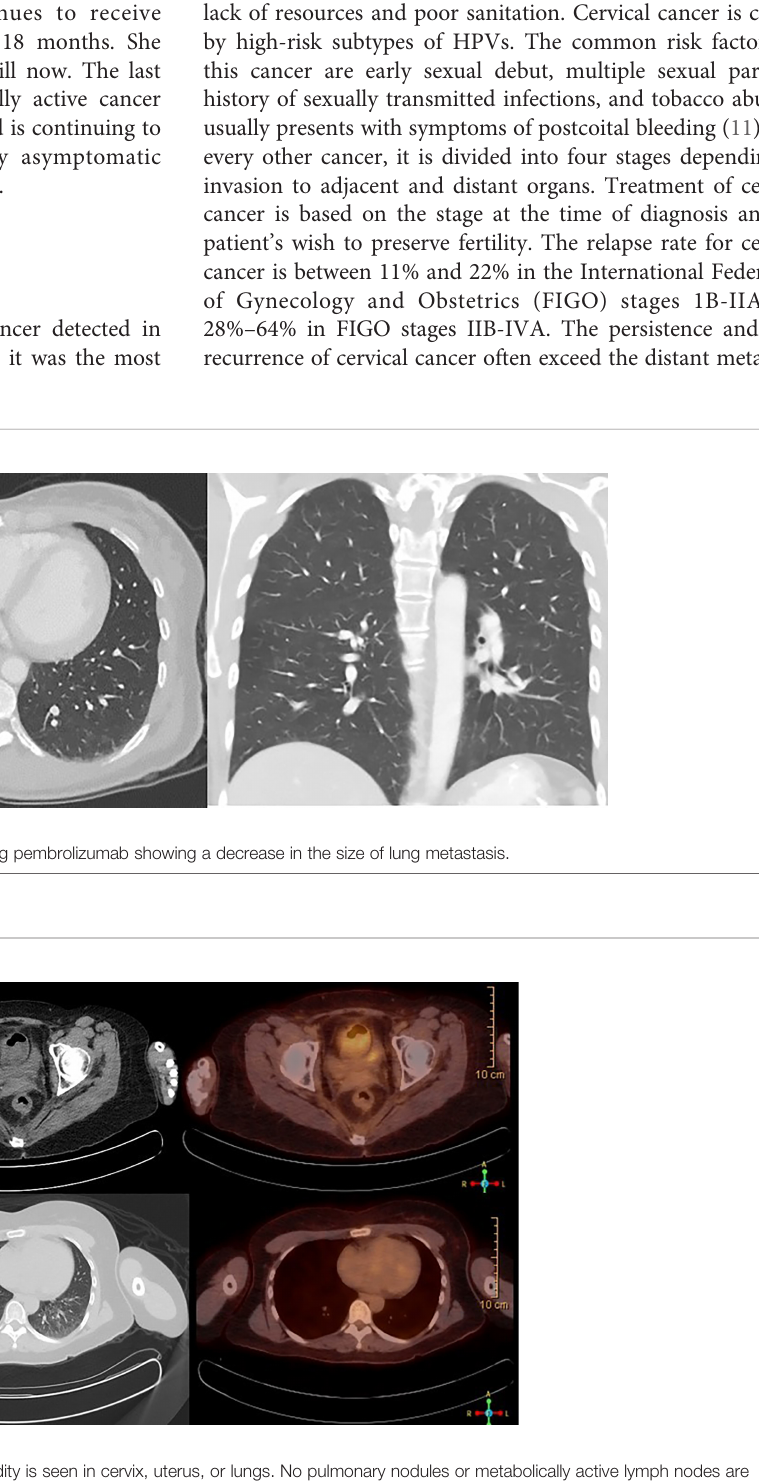
FIGURE 5 | PET/CT scan showing no abnormal FDG avidity is seen in cervix, uterus, or lungs. No pulmonary nodules or metabolically active lymph nodes are identi fi ed in the mediastinum, axilla, abdomen, and pelvis. No axillary or supraclavicular